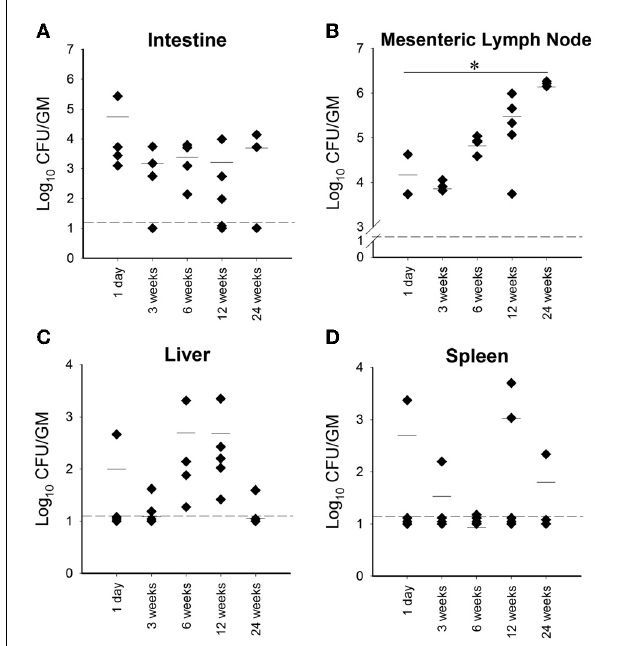
FIGURE 1 | Organ colonization from high dose orally infected mice. Graphs (A–D) ( A , Intestine; B , Mesenteric lymph node; C , Liver; D , Spleen) depict CFU/g obtained from plating serial dilutions of homogenized organs (intestines, mesenteric lymph node, liver and spleen) from mice orally infected with two consecutive doses of 10 9 CFU of M. avium subsp. paratuberculosis K10 over a 24 week period. Each dot represents one mouse, the hash mark denotes the mean, and the dotted line represents the minimum detection limit. ( ∗ p < 0 . 05).